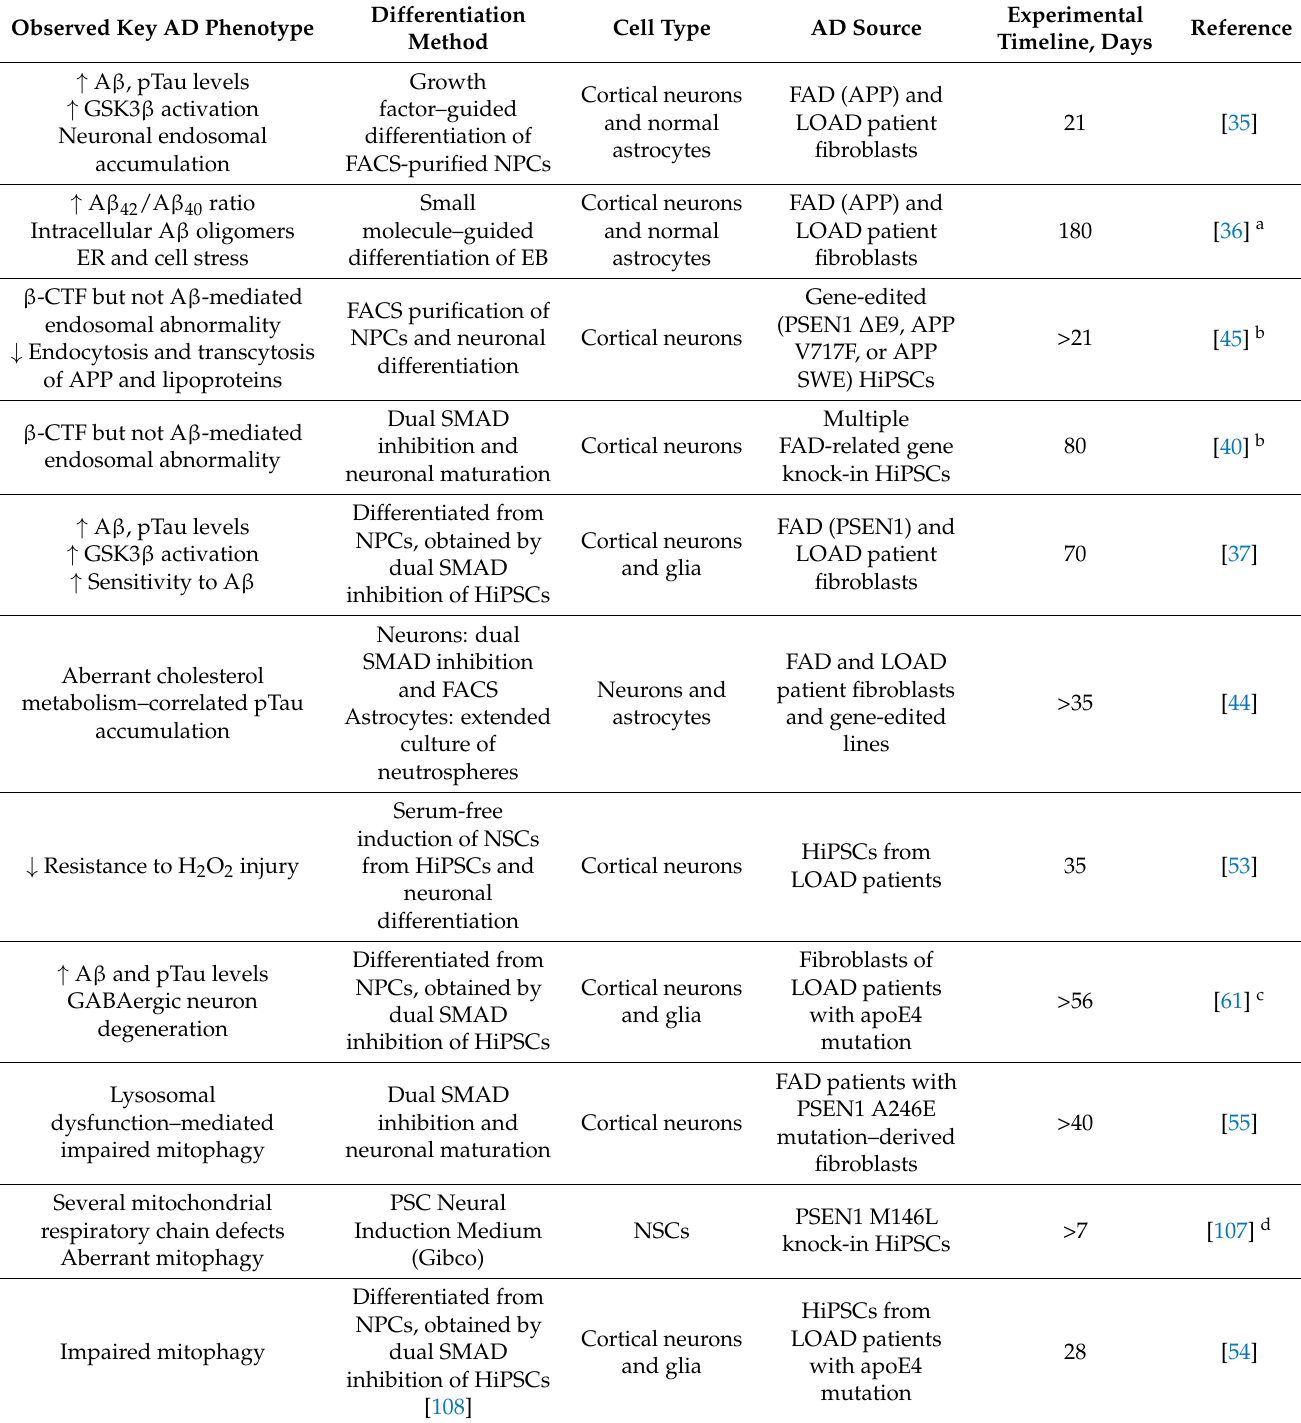
Table 1. HiPSC-derived 2D AD